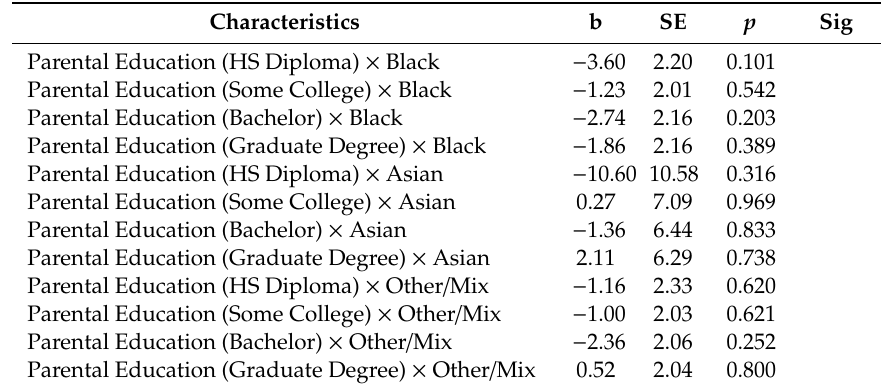
Figure 2. Parental education effects overall.